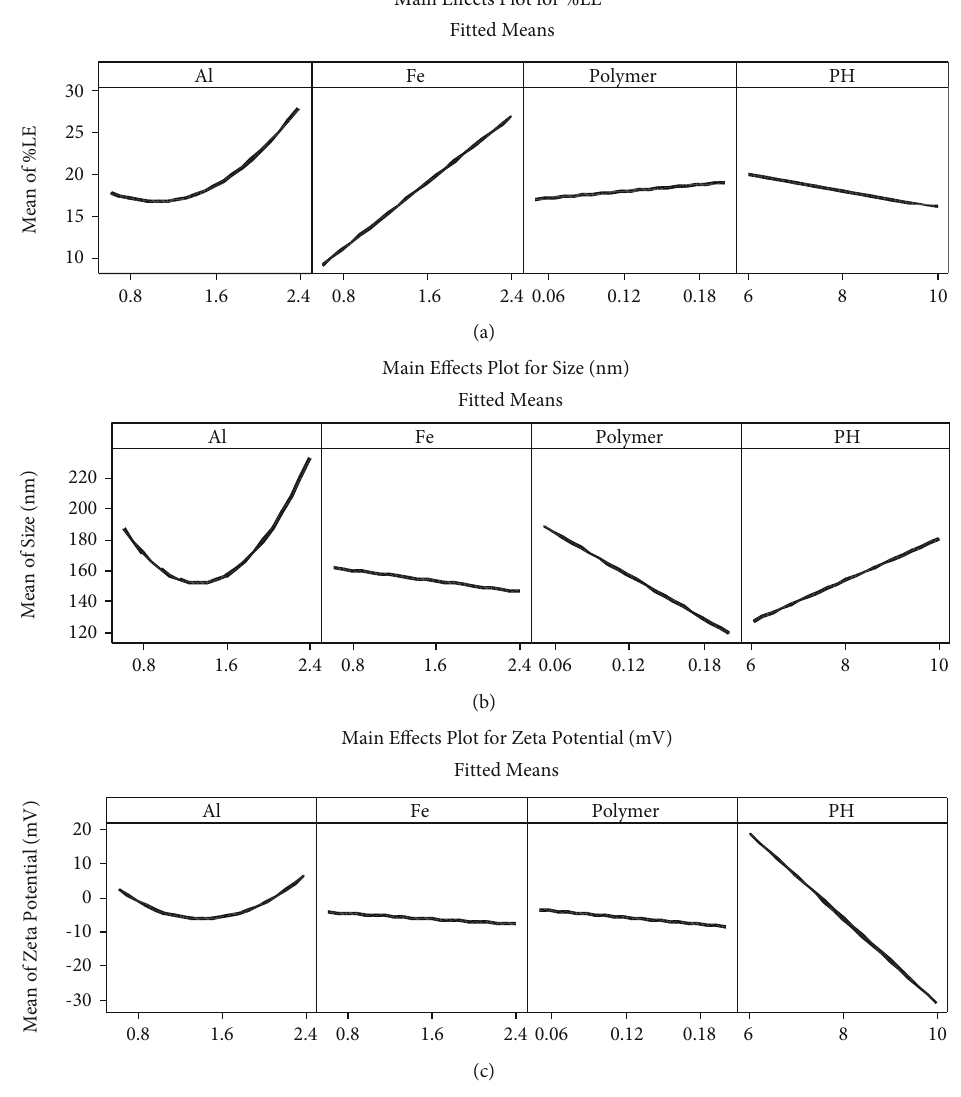
Figure 3: (a) Main e ff ects plot for % LE, (b) particle size, and (c) zeta